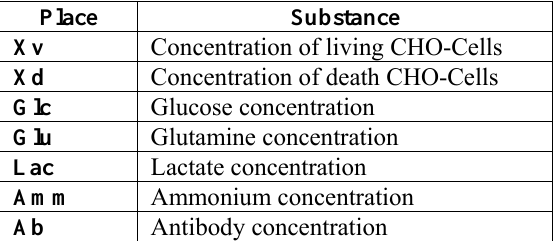
Table 6: Places of the CHO-model in Figure 25 and the corresponding Place Substance